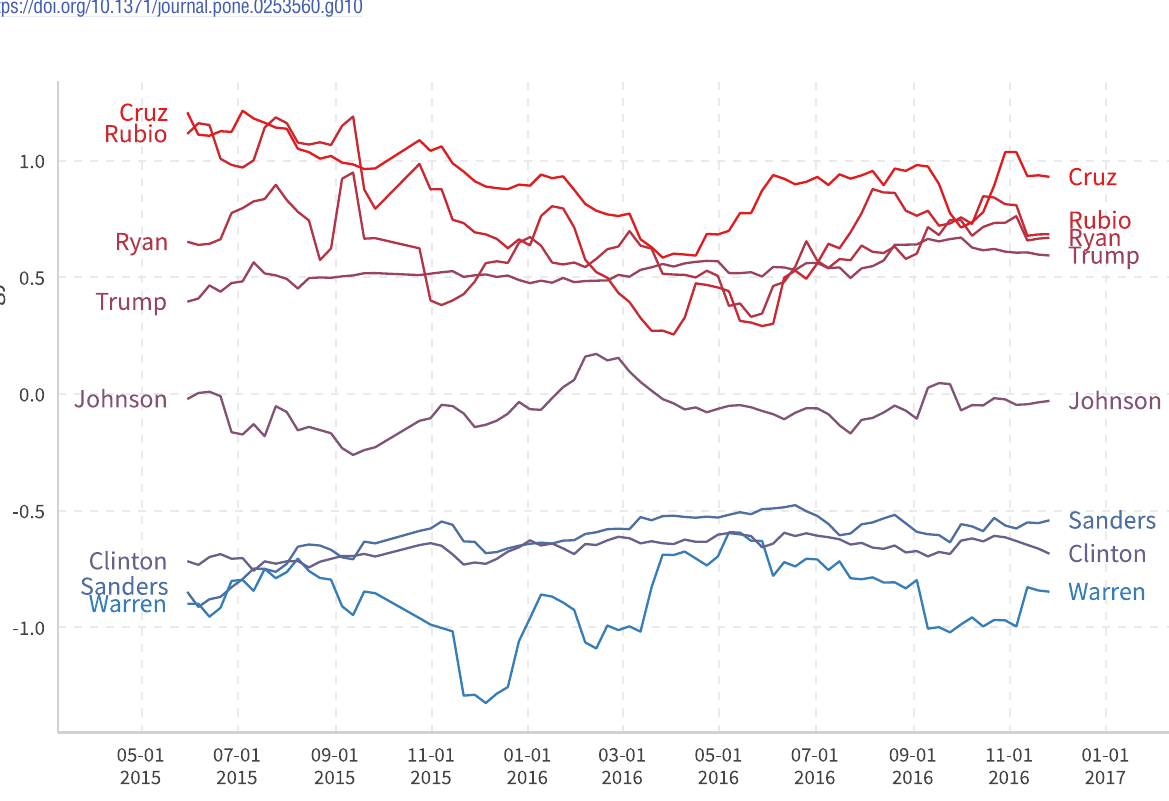
PLOS ONE | https://doi.org/10.1371/journal.pone.0253560 December1, 2021 14 /